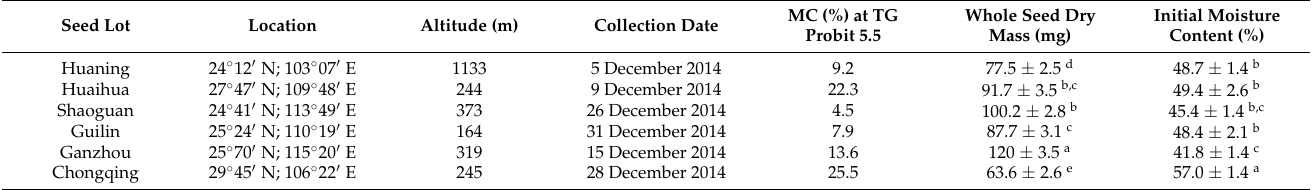
Table 1. Details of the six seed lots of Citrus sinensis ‘bingtangcheng’ studied. MC (%) at TG probit 5.5 is a measure of seed DT (the lower this MC, the higher the DT).